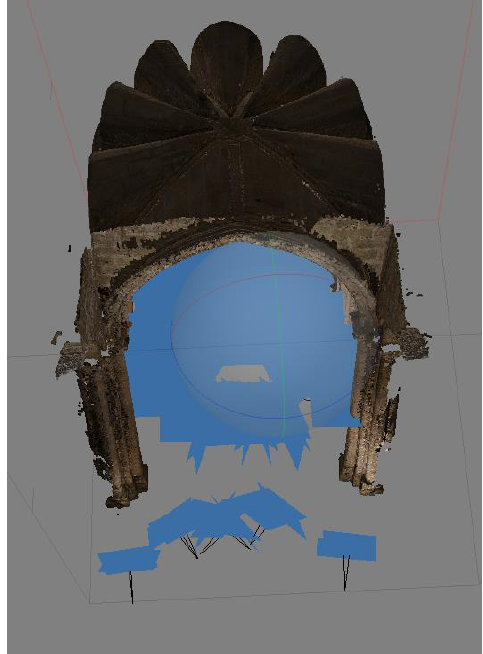
Figure 3. Santiago Ghotic apse. SRL photo